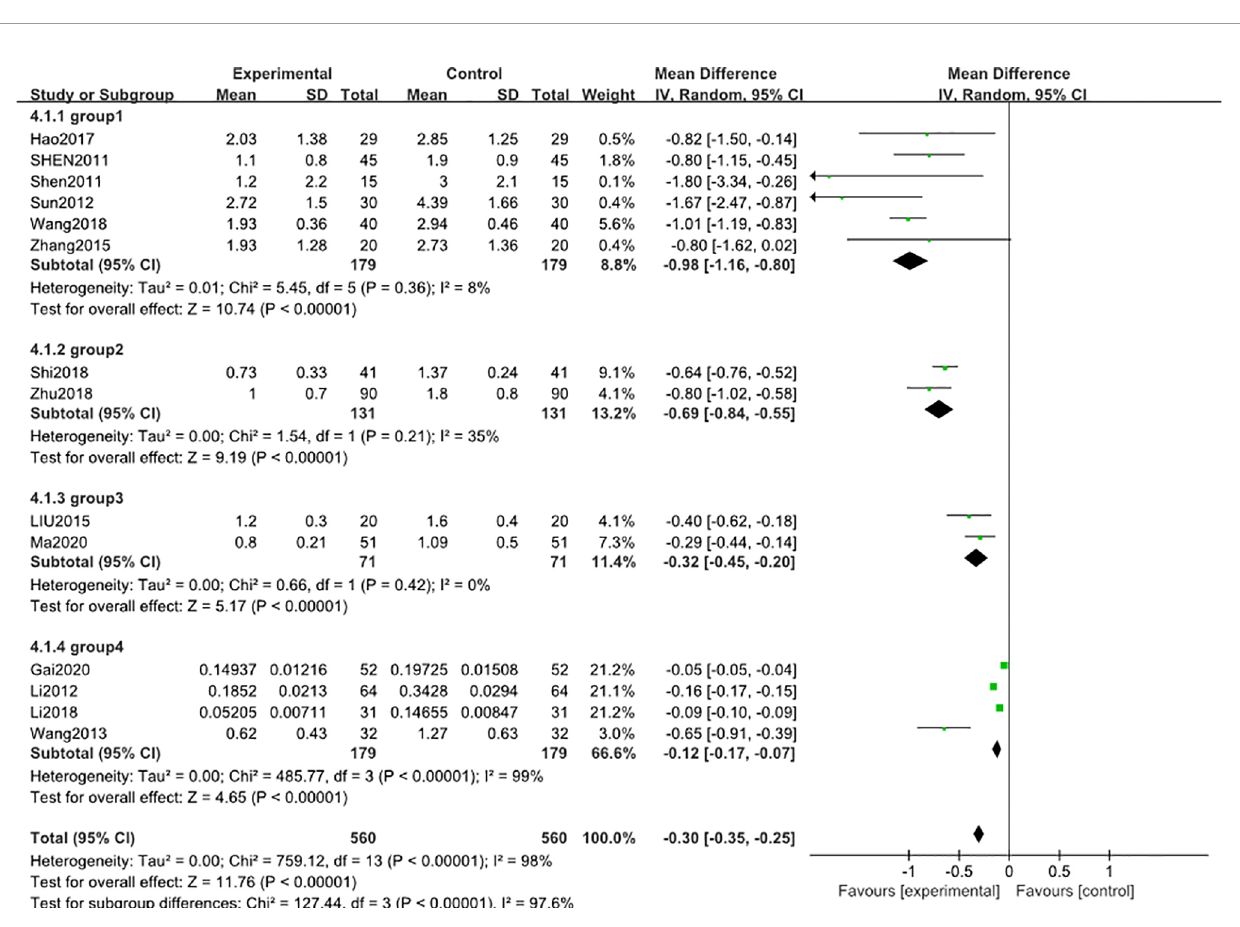
FIGURE 3 | Subgroup analysis of 24 h-UTP level after 3 months: comparison of treatment combined with TG against basic treatment (group 1: range 3 g-, group 2: range 2.8-3 g, group 3: range 1.8-2.8 g, & group 4: range 0.2-1.5